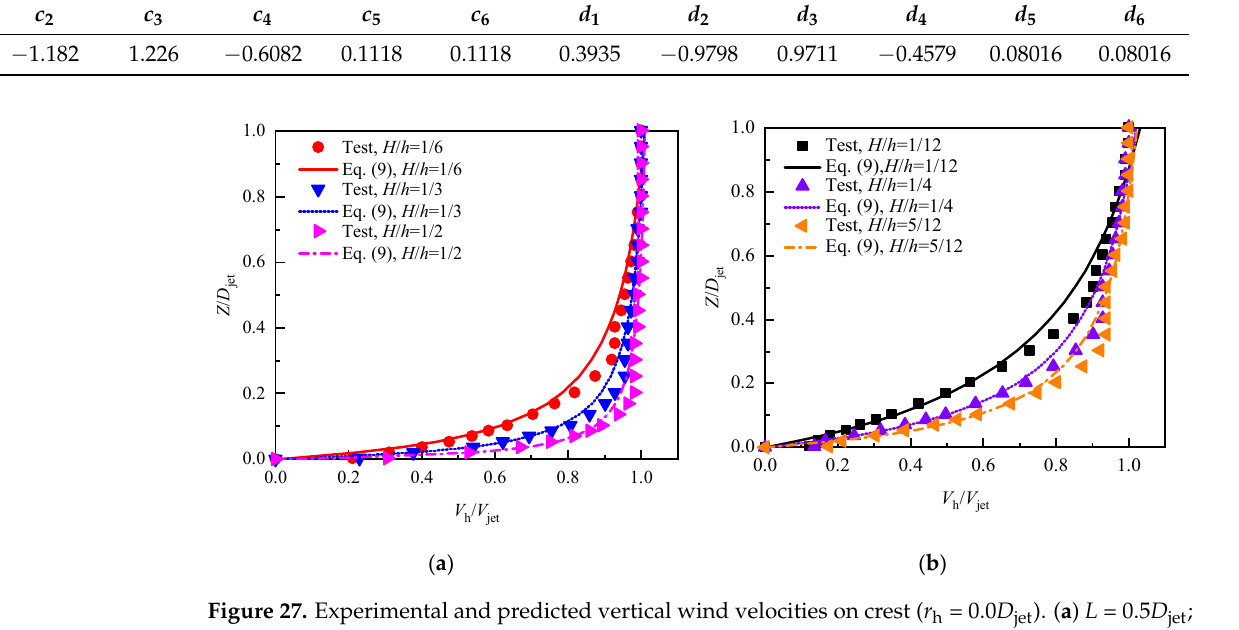
Table 8. Values of c i and d i .